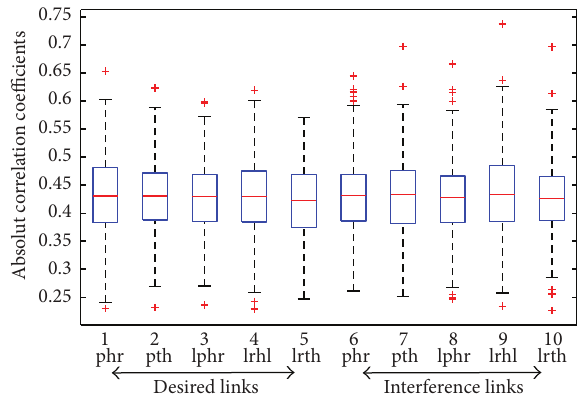
Figure 7: Correlation coefficients for different grips at high band.